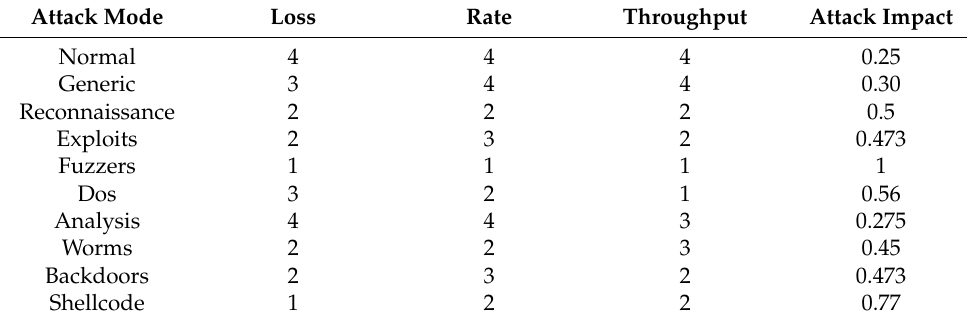
Table 9. Attack impact of each attack type.